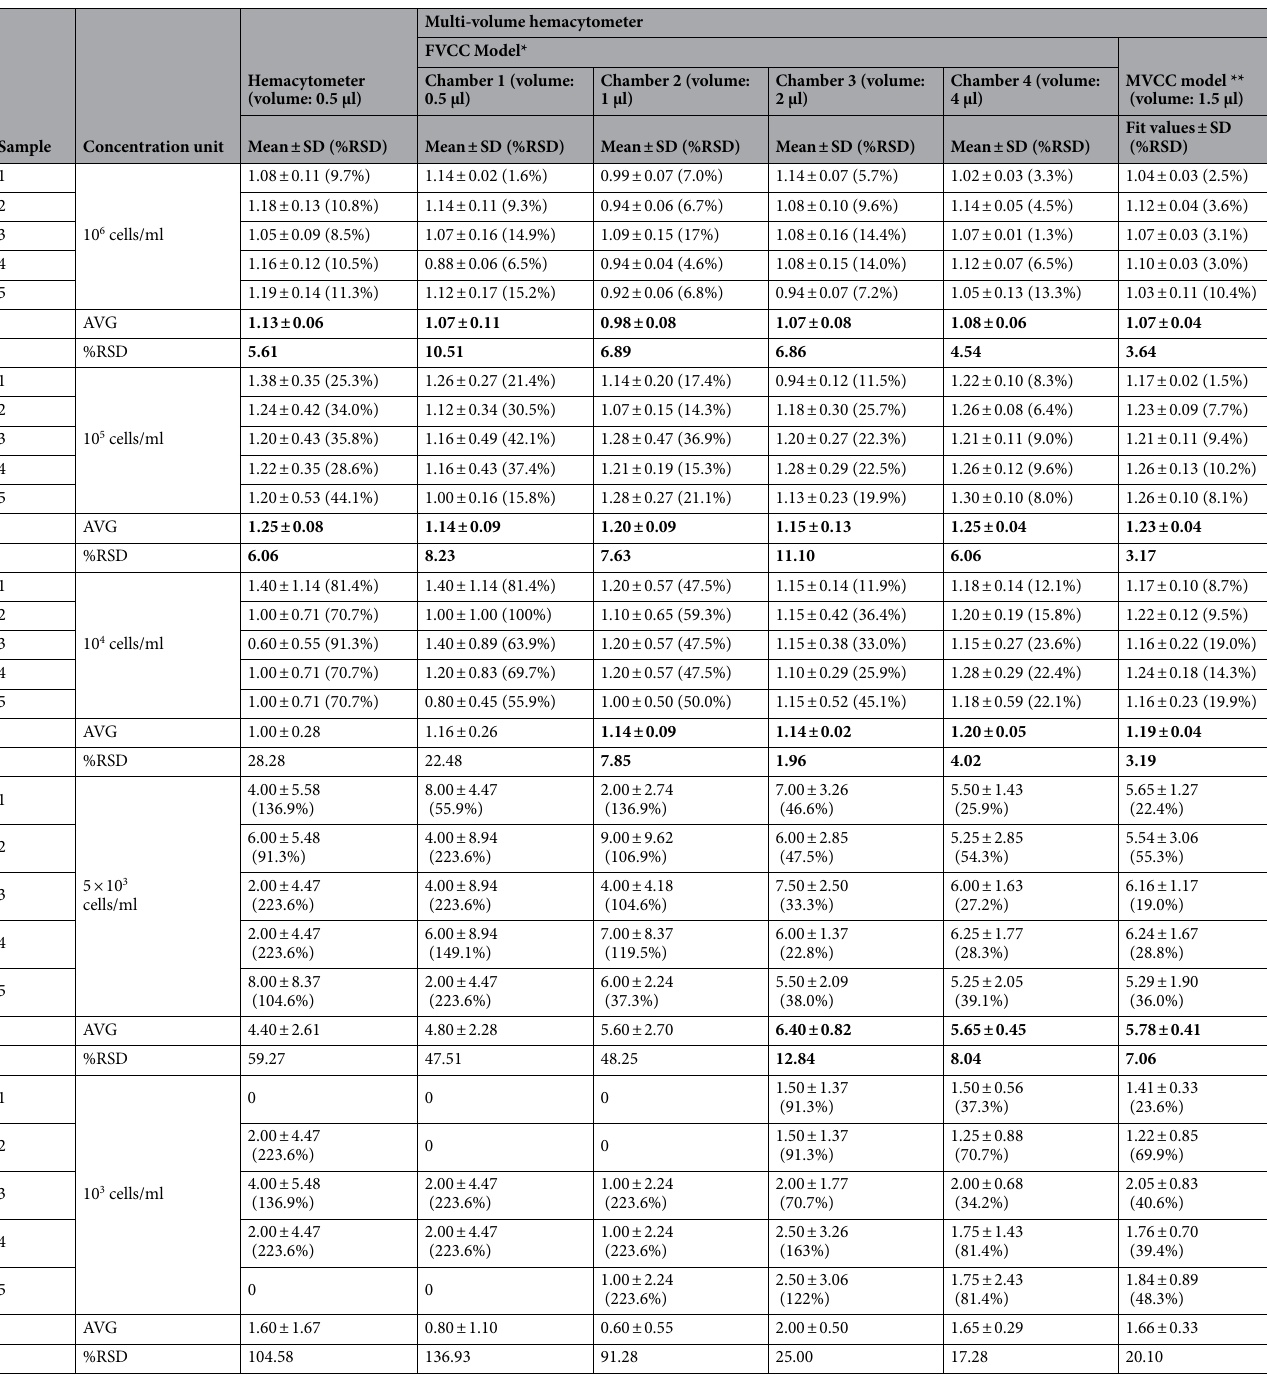
Table 1. Comparison of cell concentration measurements between a standard hemacytometer and a multi- volume hemacytometer. *FVCC Model: Fixed-Volume Cell Counting Model. **MVCC Model: Multi-Volume Cell Counting Model. Bold values Cell concentration measurement quality control pass (%RSD <